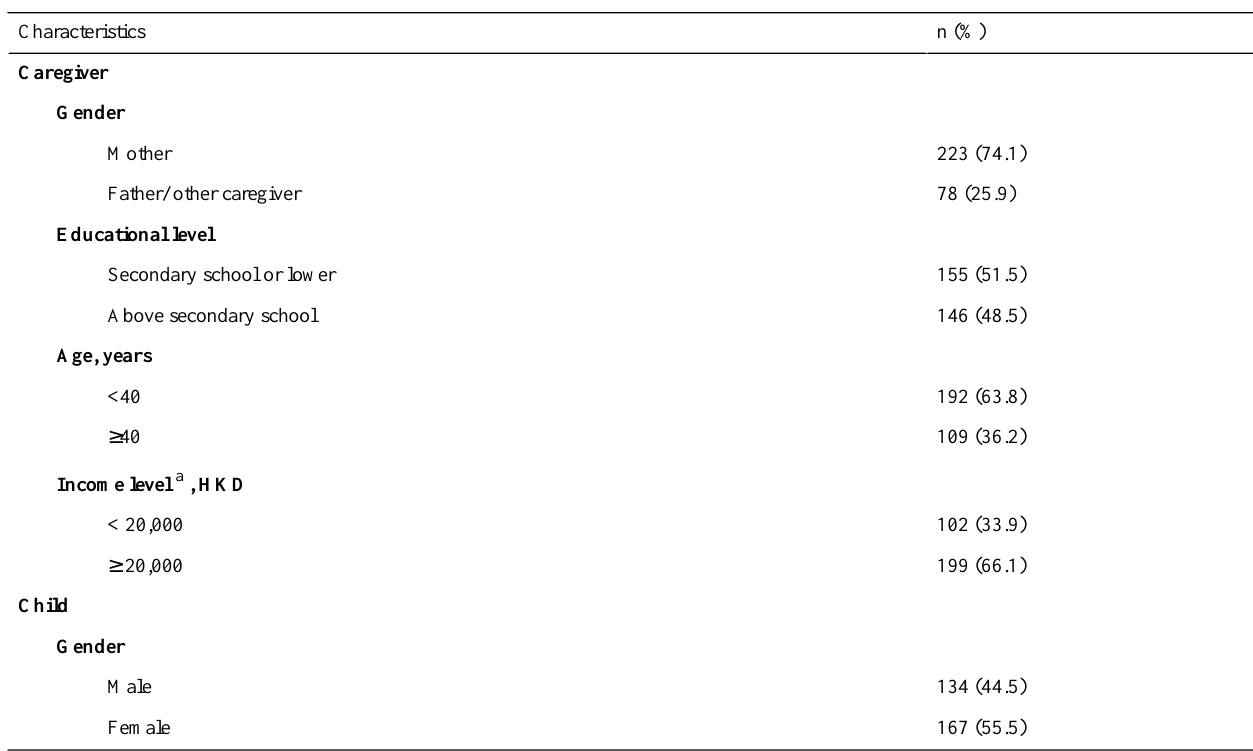
Table 3. Profile of the study population (caregivers and children) (n=301 dyads).